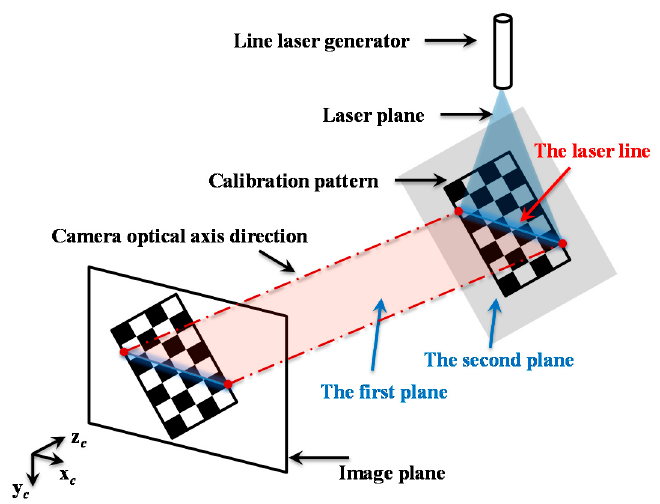
Figure 5. Two planes across the laser line.